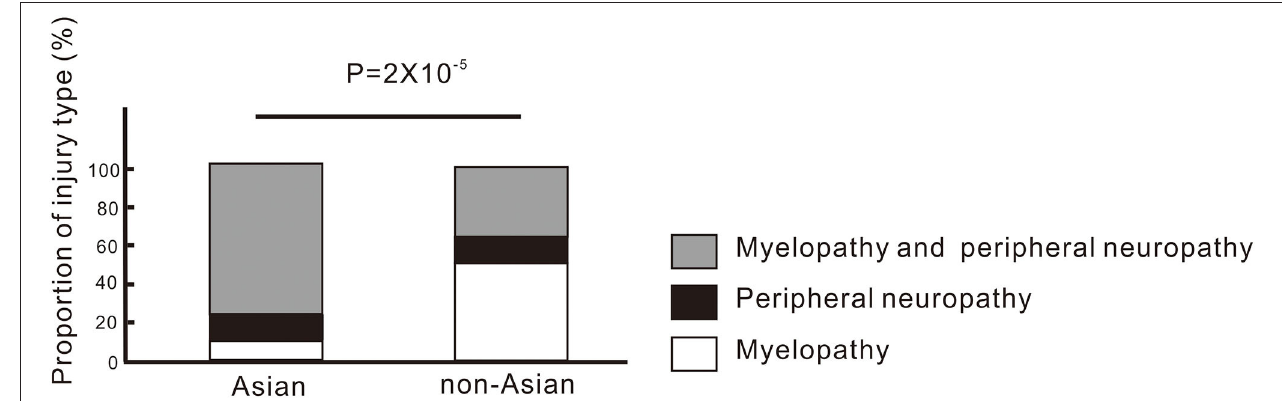
FIGURE 3 | Type of injuries involved in N 2 O-induced neurological disorders in Asian and non-Asian patients.